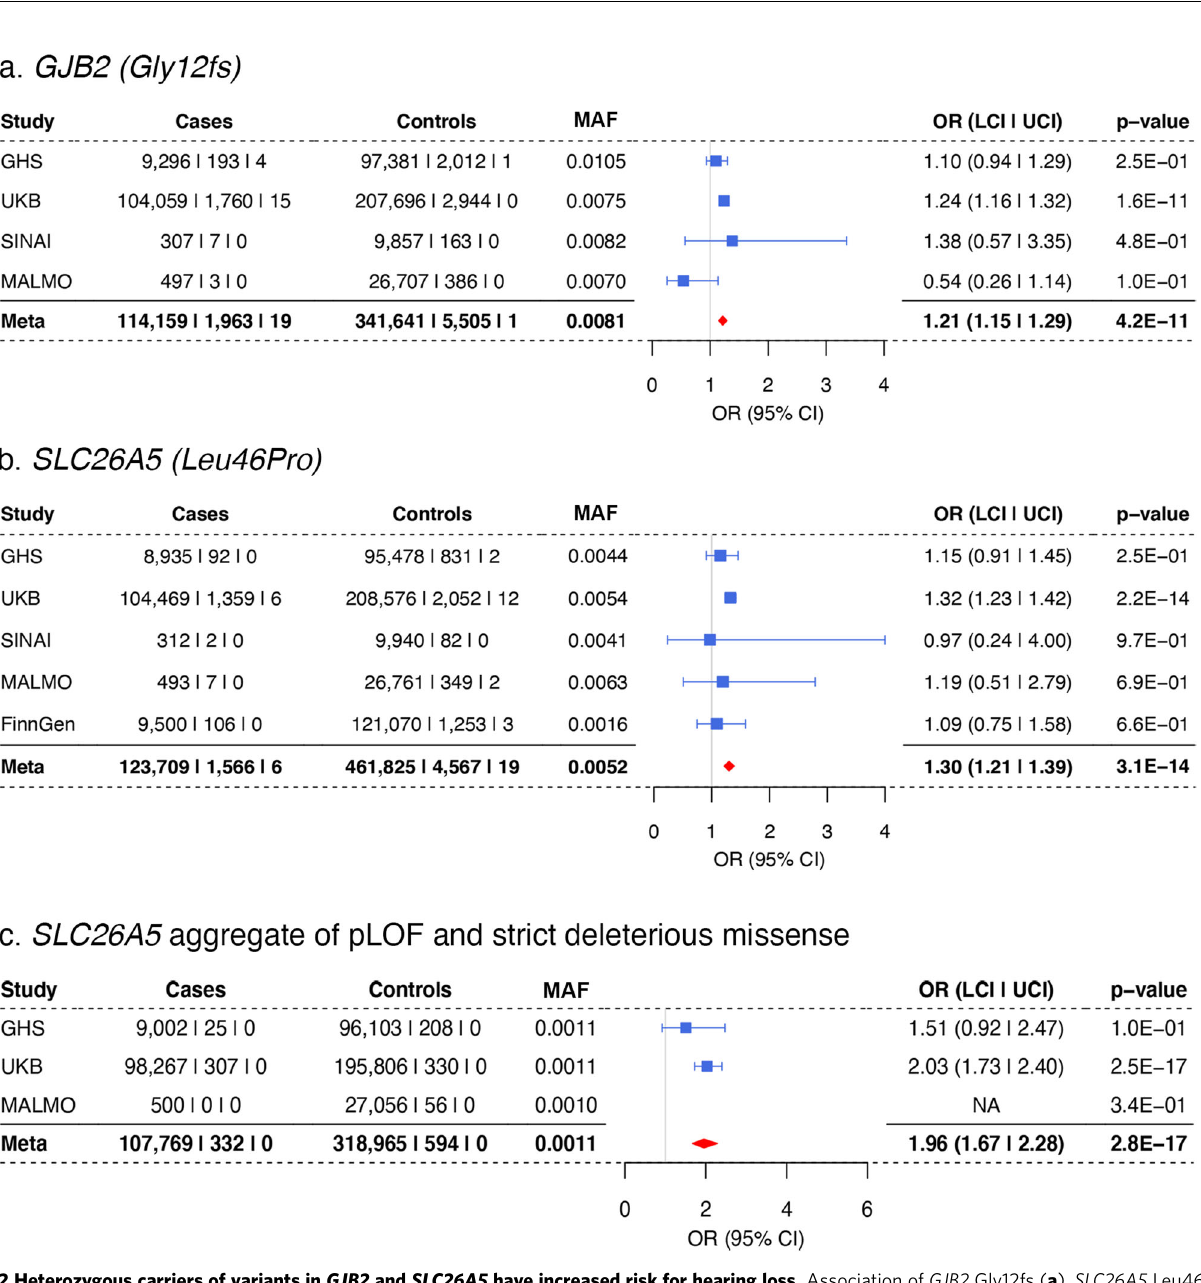
( b ) and SLC26A5 pLOF and strict deleterious missense, MAF ≤ 0.0001 ( c ) with hearing